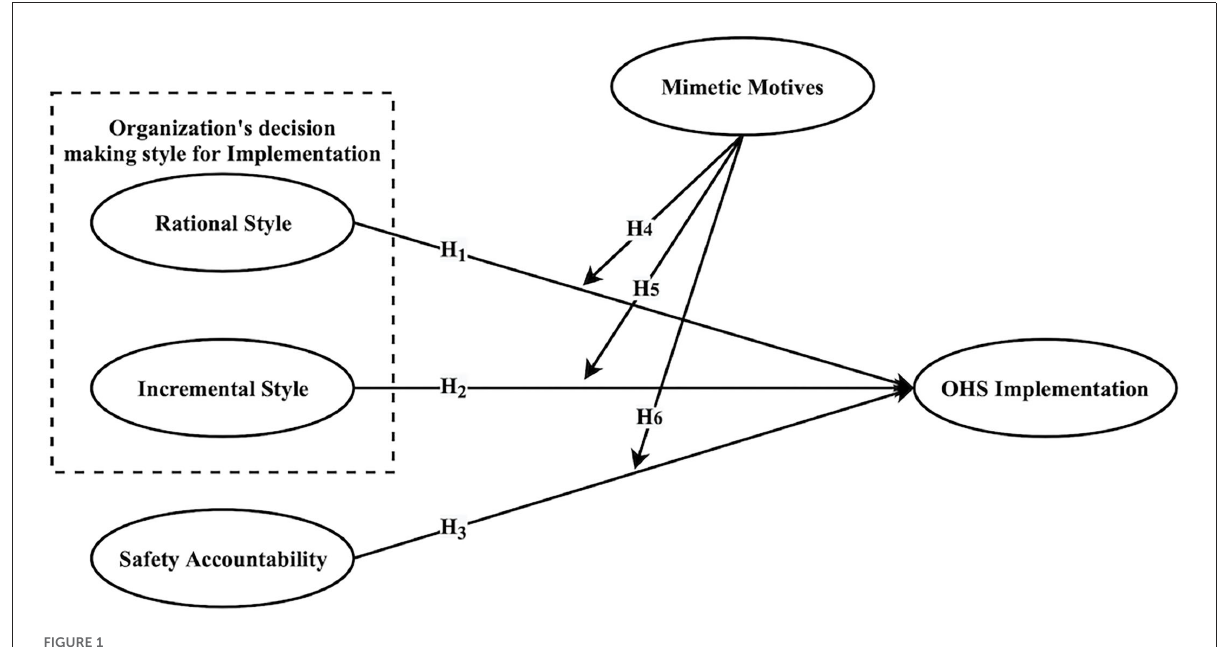
FIGURE1 Research